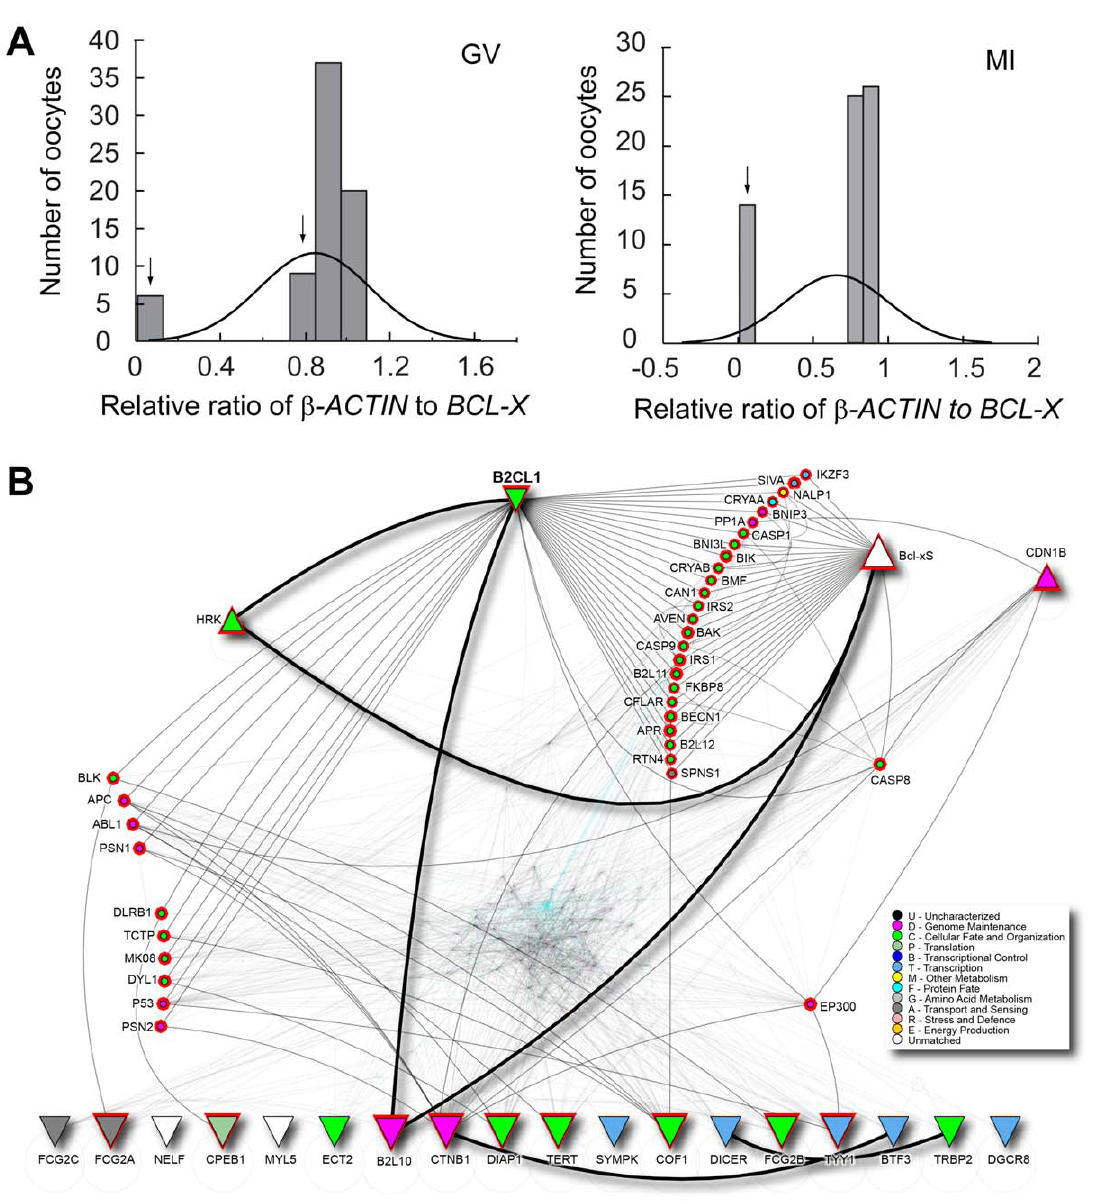
Figure 5. Expression of BCL-X in human oocytes. (A) Distribution of human oocytes obtained form 43 patients based on their BCL-X expression in either germinal vesicle stage (GV - left) or meiosis I stage (MI - right). Arrows point to groups of oocytes with insufficient endowment of BCL-X transcript. (B) Visualization of protein interaction network that connects BCL-X (BC2L1) with other targets known to be deregulated in arrested human embryos. Node shape, represented by triangles, indicates trends of expression. Shape of triangles pointing up corresponds to genes up-regulated and triangles pointing down correspond to genes down-regulated in arrested human embryos; circles represent direct interacting partners that link BCL-X (BCL2L1) to up- and down-regulated targets. Red highlight on nodes represents the set of cross-linked proteins. Node color is based on gene ontology as per legend. To reduce network complexity, all other nodes and edges are made partially transparent.